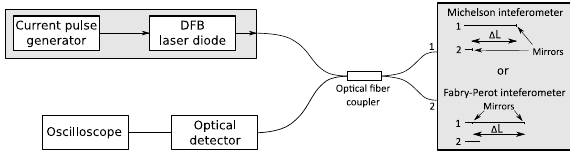
Figure 2. Set-up of proposed frequency modulator with Michelson fiber interferometer and Fabry–Perot fiber